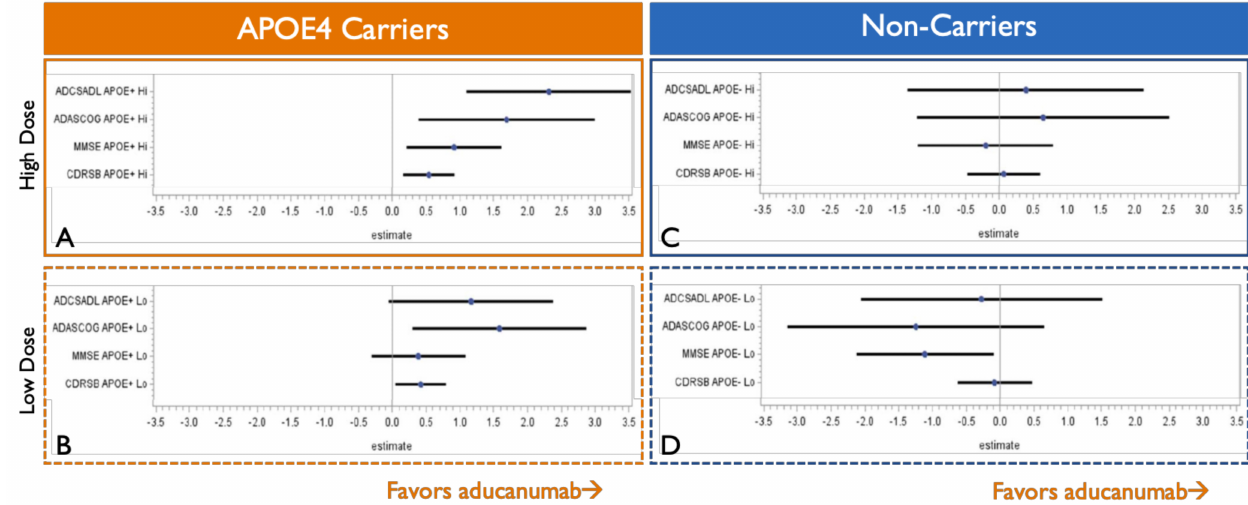
Figure 6. Carriers of ε 4 allele of apolipoprotein E (APOE4) drive the overall efficacy of aducanumab in the EMERGE Phase 3 study. Only a single EMERGE Phase 3 trial showed clinical efficacy of aducanumab. Diagrams adapted from the FDA Advisory Committee Briefing Book illustrate point estimate effects of aducanumab in the EMERGE trial on a functional (Alzheimer’s Disease Cooperative Study—instrumental Activities of Daily Living Inventory (ADCSADL)), cognitive (Alzheimer’s Disease Assessment Scale—Cognitive subscale (ADAS-Cog) and Mini-Mental State Examination (MMSE)), and a composite clinical outcome (Clinical Dementia Rating—Sum of Boxes (CDRSB)). Panels ( A ) and ( B ) show effects of high and low doses in APOE4 carriers, and panels ( C ) and ( D ) show effects in APOE4 non-carriers, suggesting that the overall efficacy of aducanumab is derived from the APOE4 carrier population with minimal clinical benefits observed in APOE4 non-carriers